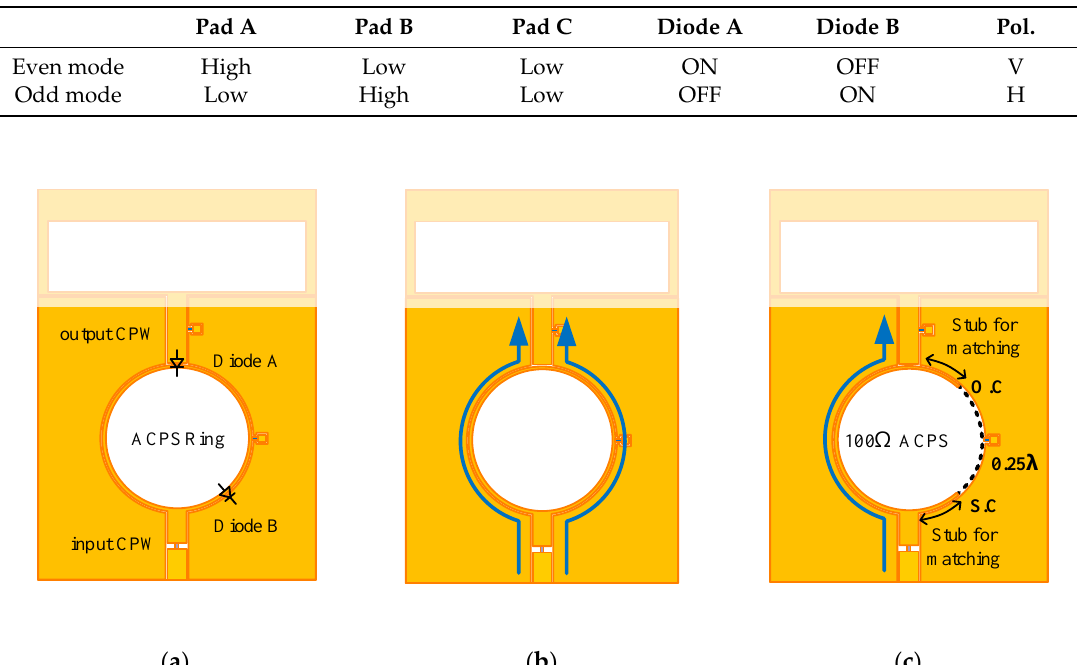
Table 2. Switching states of the diodes and the generated polarization modes.